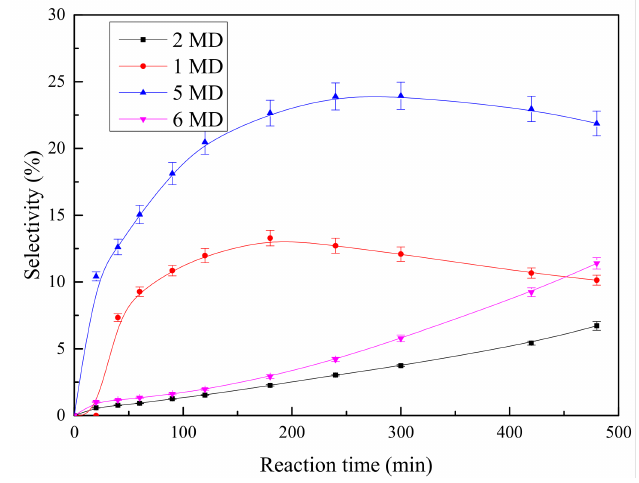
Figure 11. Selectivity of MTs with time on stream over CoMo/AZ (reaction conditions: the same as the conditions in Figure 8).